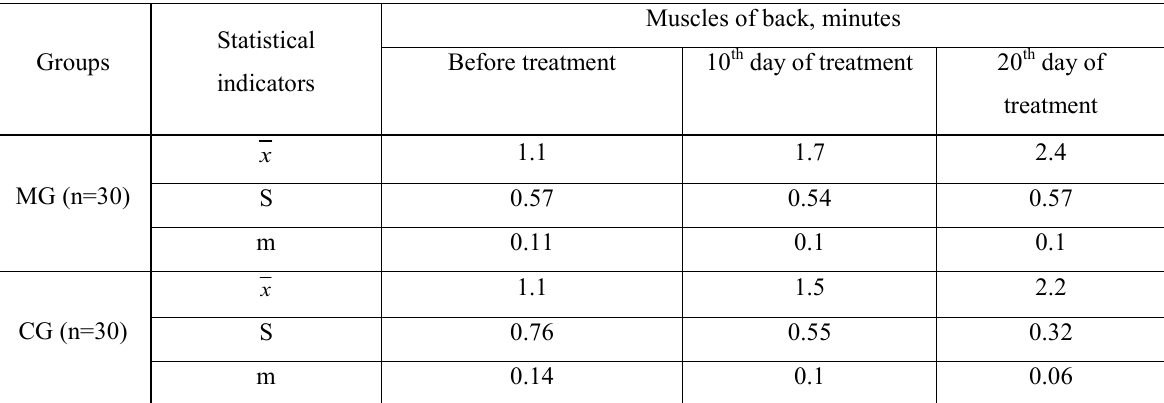
Dynamics of back muscles functional abilities to manifest long-term